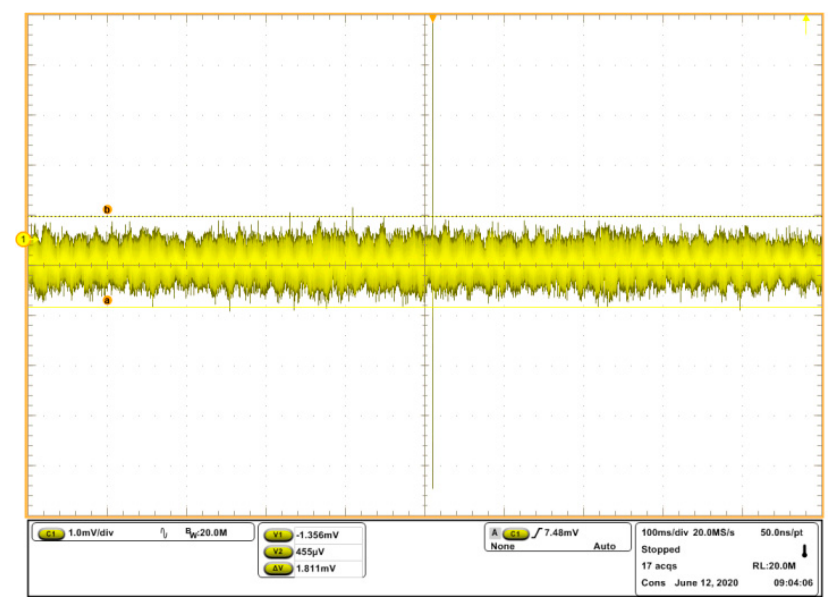
Figure 20. Measured ripple of the power amplifier.